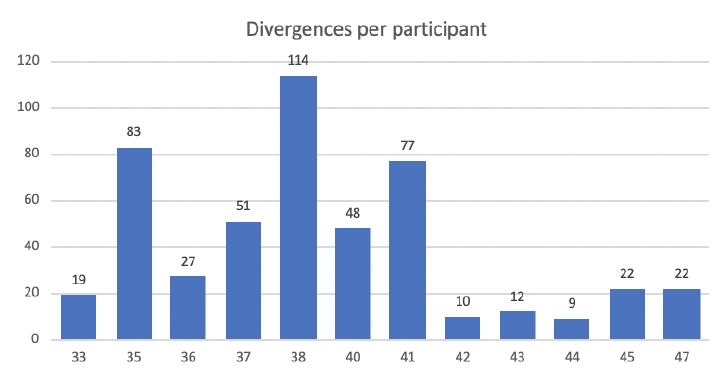
Figure 7. Occurrences of divergences per participant.